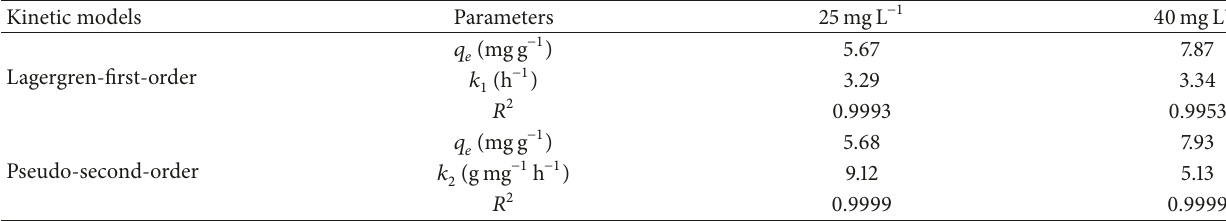
Table 3: Parameters of kinetic models for As(V) onto CS-Fe.